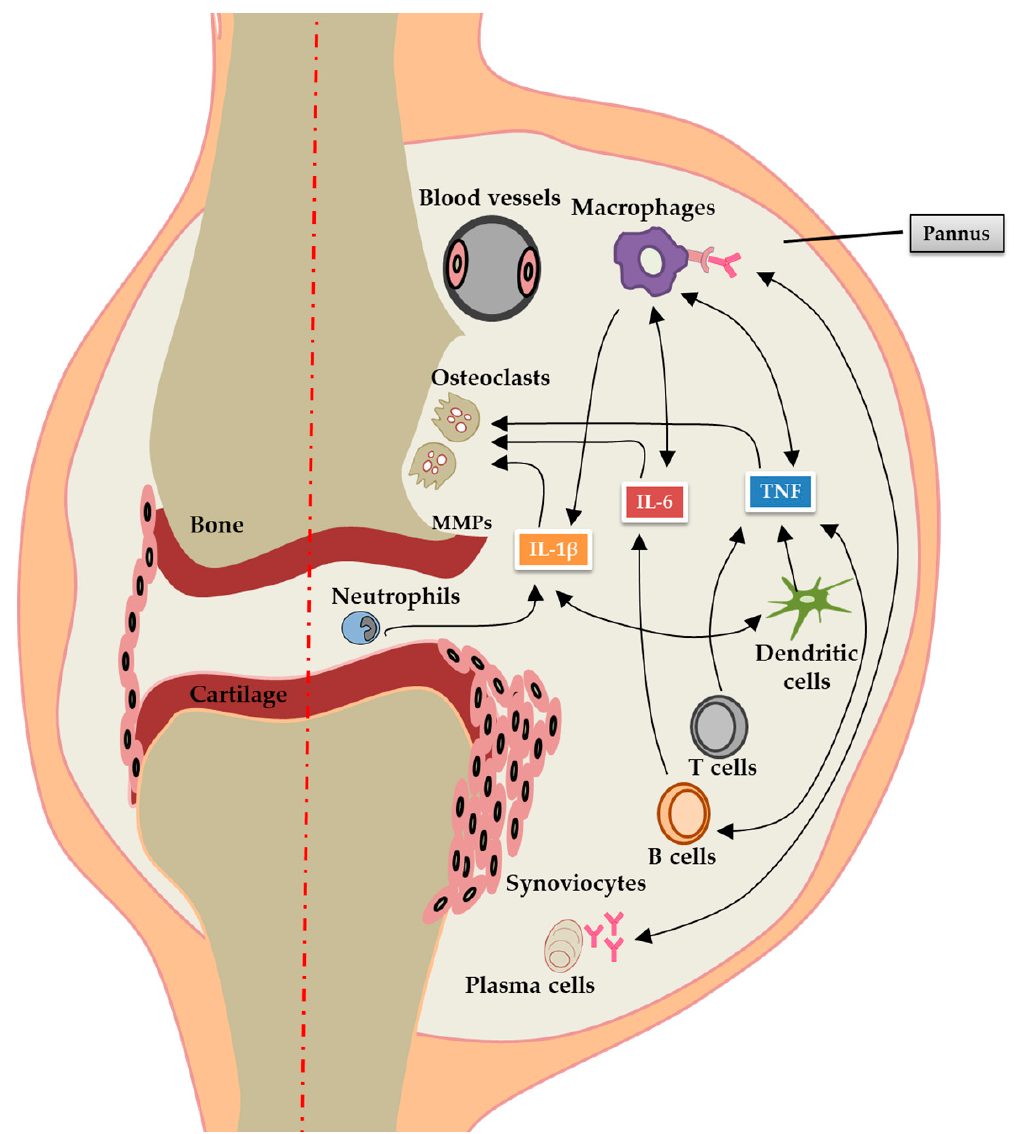
Figure 1. Pathogenesis of RA: pannus formation and systemic inflammation. Inflammation in RA is caused by activation of B cells, T cells, plasma cells, neutrophils, dendritic cells and macrophages, which releases proinflammatory cytokines such as TNF- α , IL-1 β , and IL-6. These cytokines cause local joint damage through increased production of MMPs and activation of osteoclasts. TNF- α , IL-1 β , and IL-6 also leak out to the blood stream resulting in systemic inflammation. TNF, tumor necrosis factor; IL, interleukin; RA, rheumatoid arthritis; MMPs, matrix metalloproteinases.